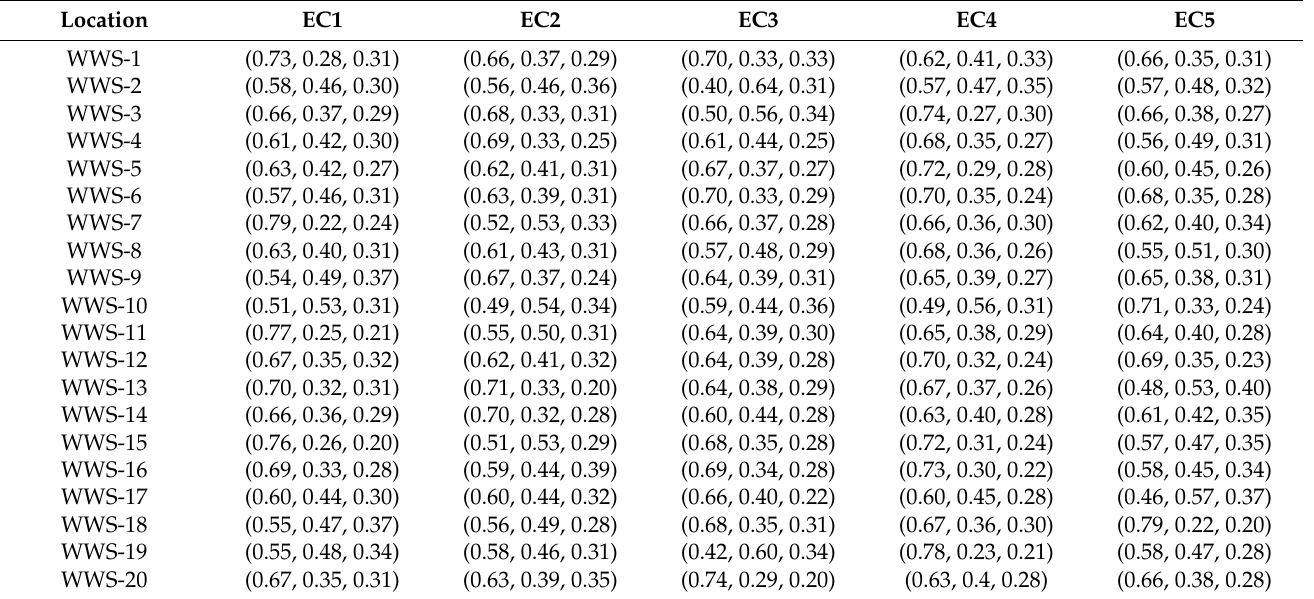
Table A6. Spherical fuzzy decision